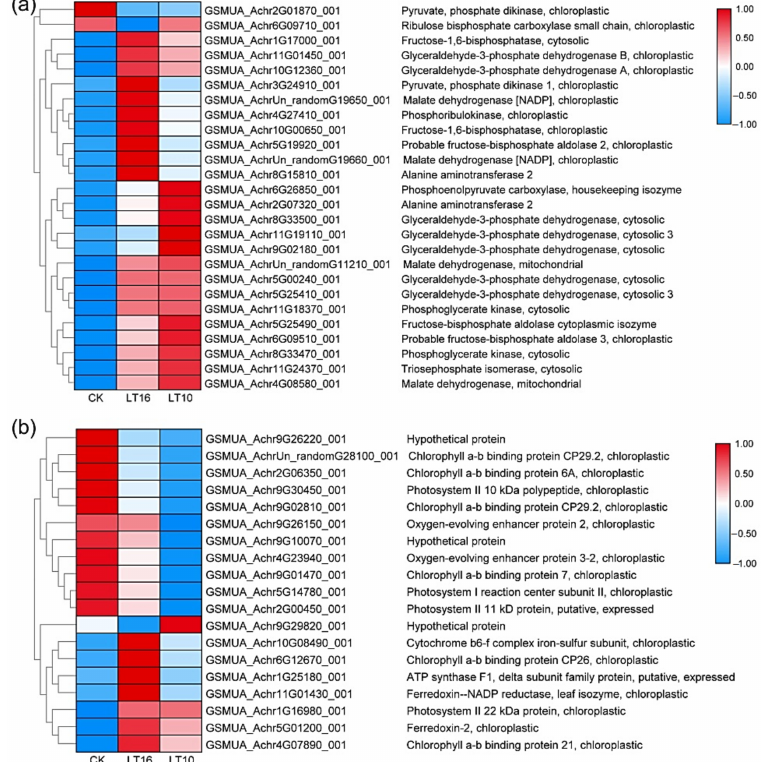
Figure 4. Heatmap showing the changes in expression (expected number of fragments per kilobase of transcript sequence per millions base pairs sequenced) of photosynthesis related genes in banana ( Musa spp. AAA) in response to chilling stress. ( a ) DEGs related to carbon fixation; ( b ) DEGs related to photosynthesis and photosynthesis-antenna proteins. CK the control, LT10 LT of 10 ◦ C, LT16 LT of 16 ◦